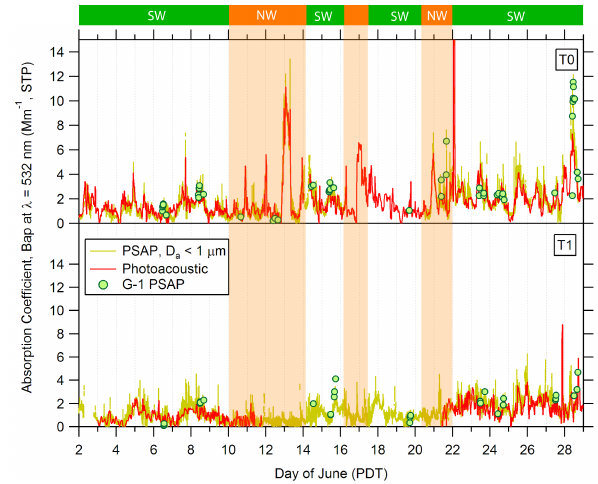
Fig. 19. Comparison of absorption coefficient measured at λ = 532nm by PSAP and photoacoustic instruments at the T0 and T1 sites and by PSAP ( λ = 522nm) aboard the G-1 during overpasses at the respective